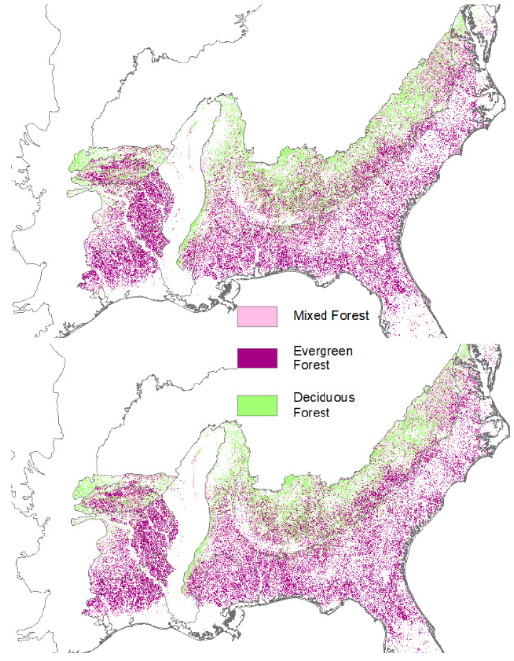
Figure 6. Forest land classes during 2001 (upper panel) and 2016 (lower panel).